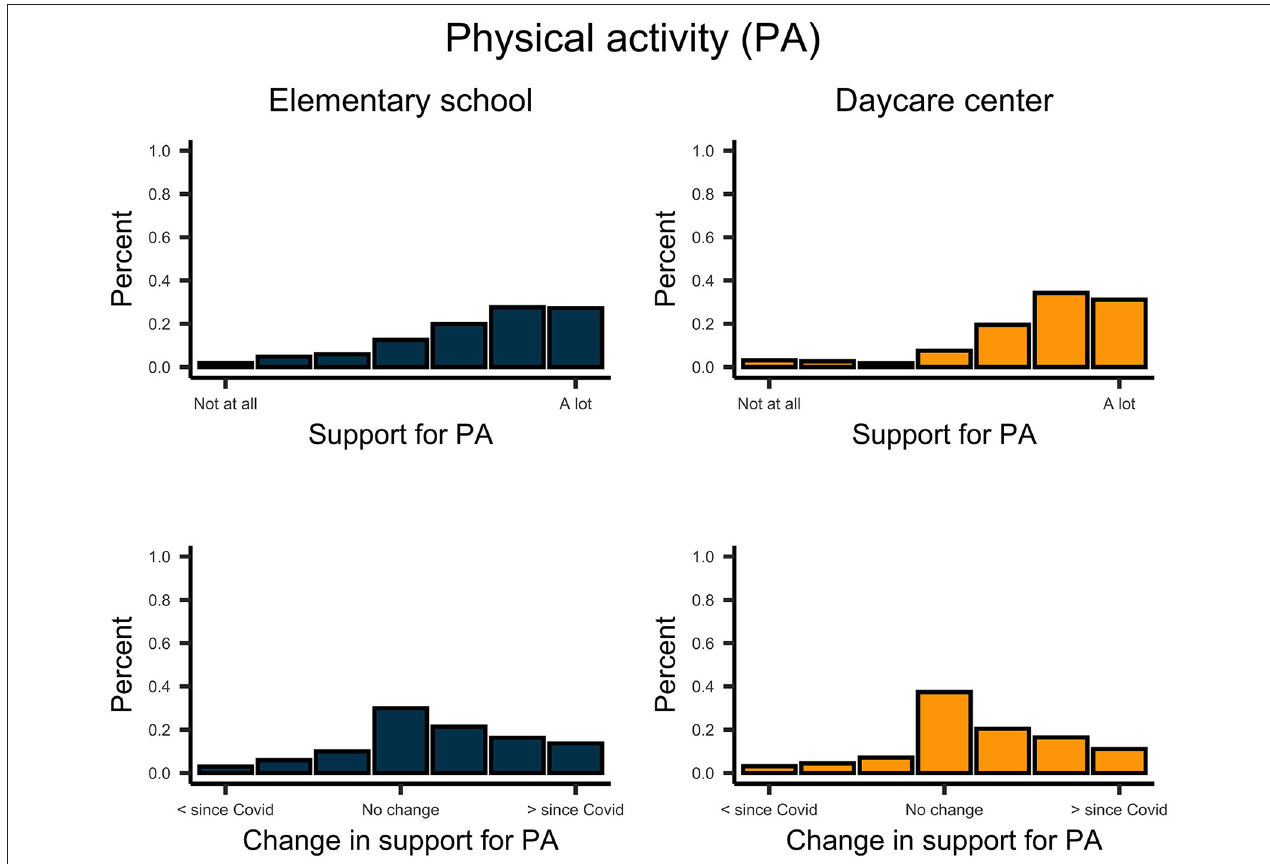
FIGURE 8 | Upper plots indicate the support of parents for the physical activity in school- and preschool-aged children. Lower plots indicate the change of this support since the COVID-19